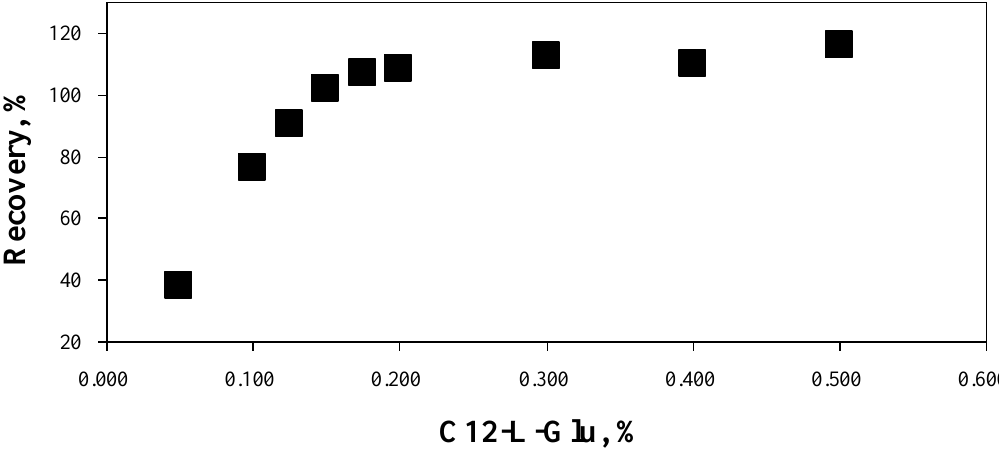
Figure 8. Refolding of HyHEL-10 scFv in the presence of 0.8 M arginine as a function of C12- L -Glu